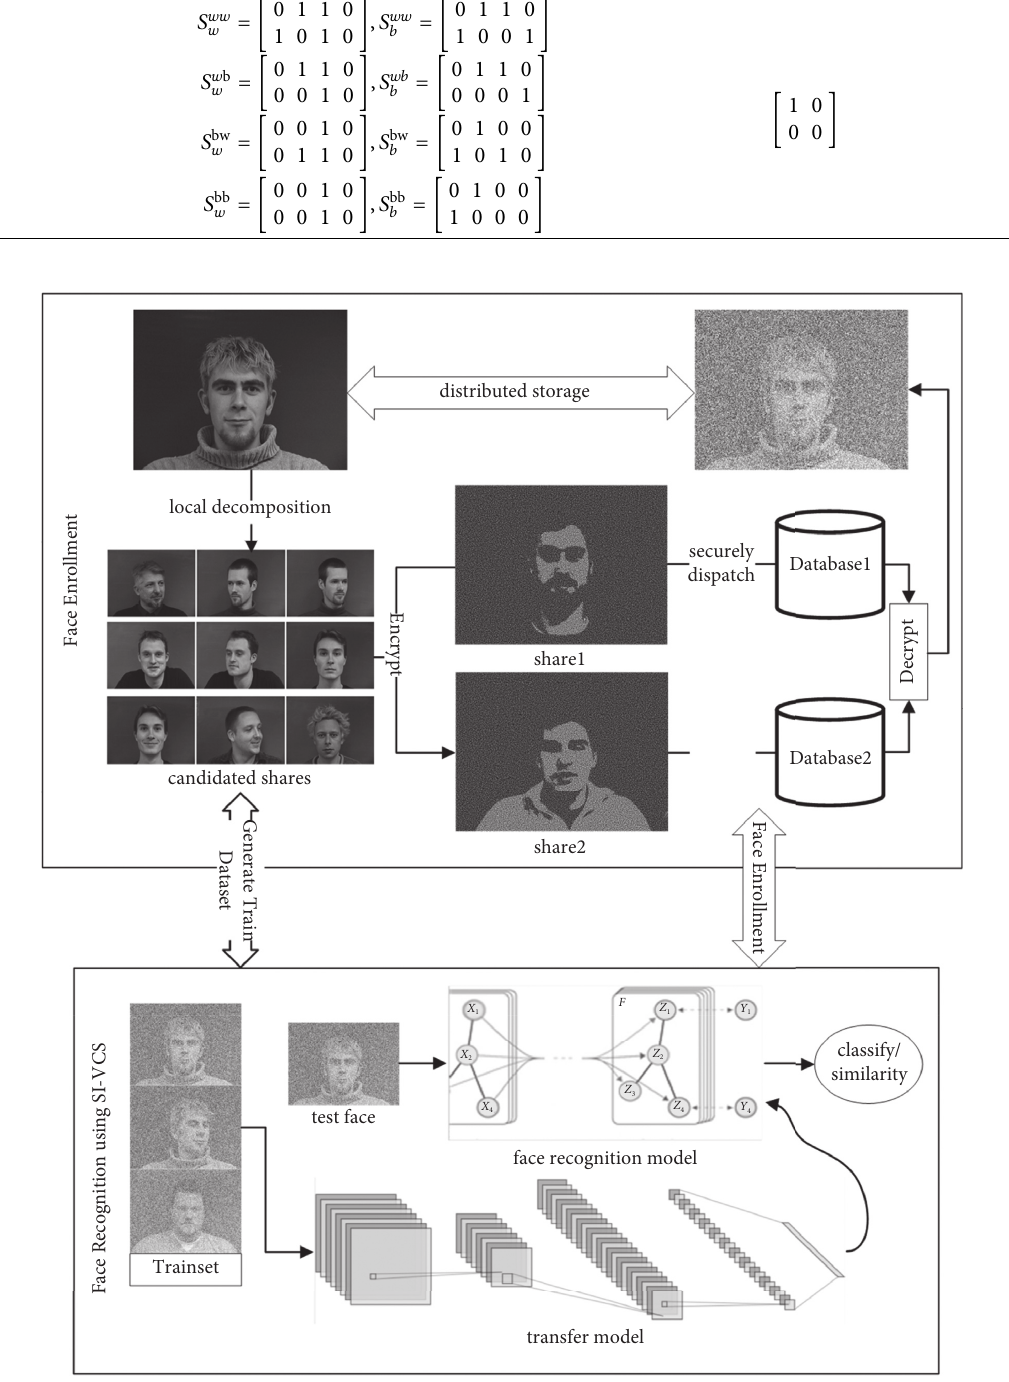
Figure 1: The flowchart of the proposed approach for distributing and matching face images.